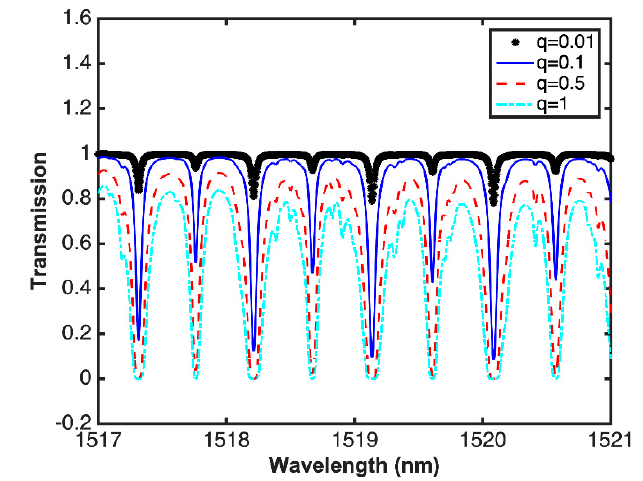
Figure 5. Simulations of the acetylene transmission power at different concentrations.